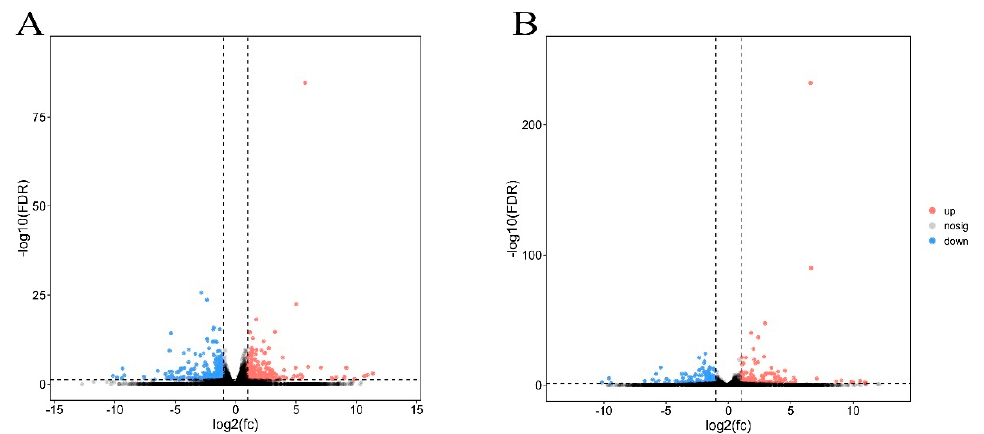
Figure 1. Volcano plots of differentially expressed genes (DEG). ( A ) Cry1F-resistant vs. susceptible O. furnacalis . ( B ) Cry1Ie-resistant vs. susceptible O. furnacalis . The scattered dots in the figure indicate each gene: red indicates that the gene is up-regulated, blue indicates that the gene is down-regulated and gray genes indicate no differential expression.